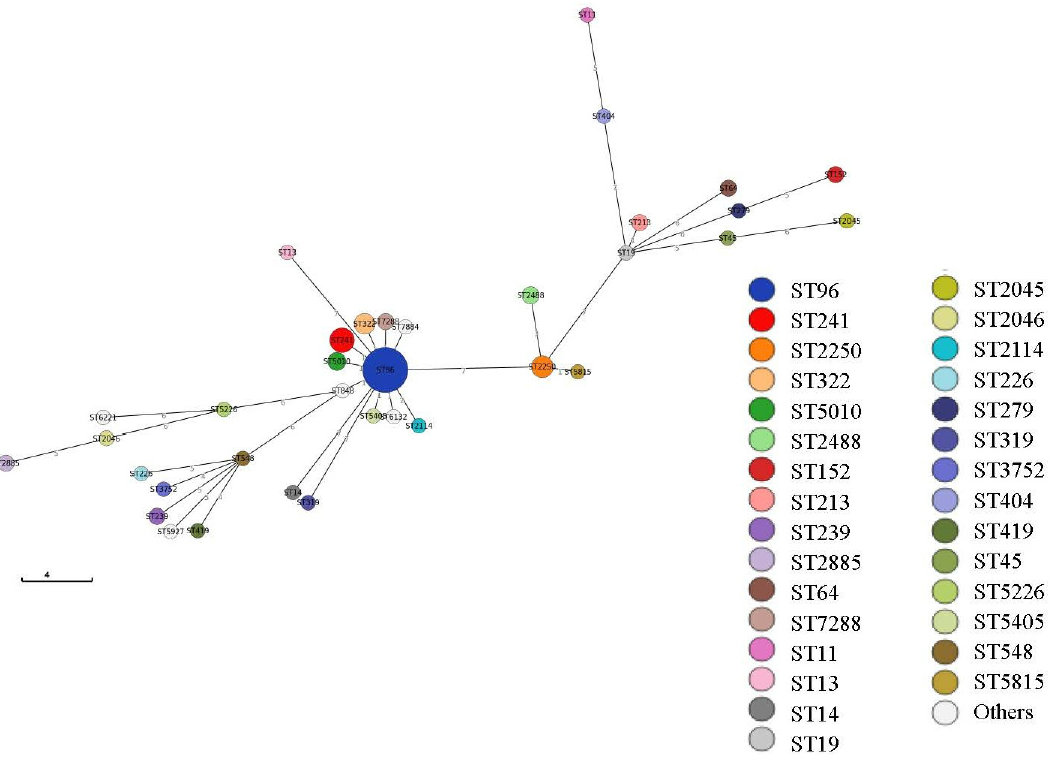
Figure 1. Improved minimal spanning tree called MSTree V2 based on 1833 Salmonella enterica serovar Schwarzengrund isolates that were typed via Achtman 7 gene multilocus sequence type and registered in EnteroBase [24] on 5 March 2021.